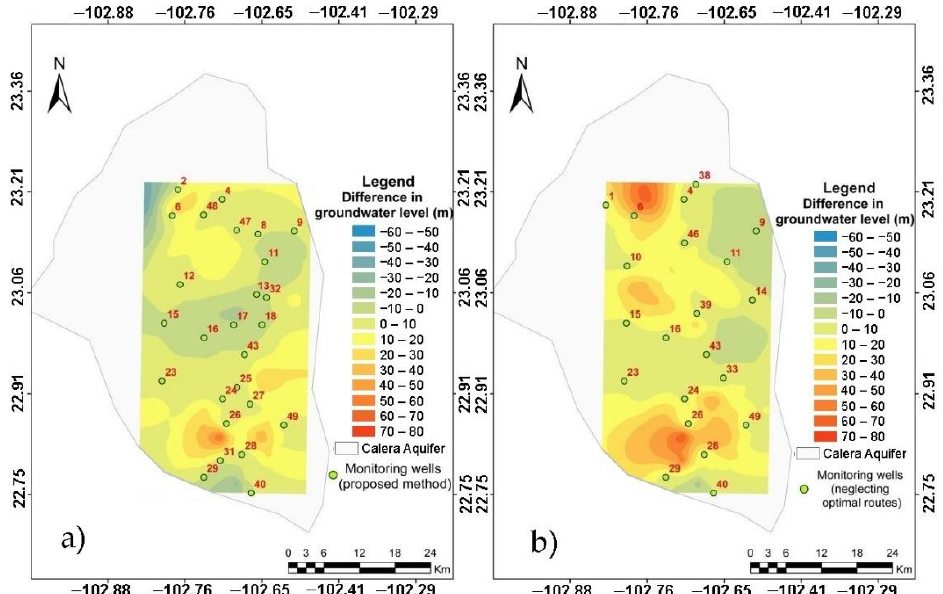
Figure 12. Differences between the groundwater-level estimates using the complete monitoring network: ( a ) the network selected with proposed method, and ( b ) the network selected with the Júnez-Ferreira method.